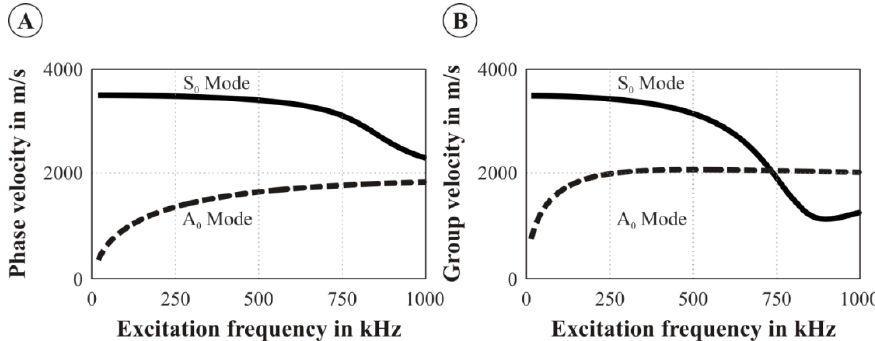
Figure 2. Dispersion diagrams for a GF/PA6 plate. ( A ) Phase velocity; ( B ) Group velocity.